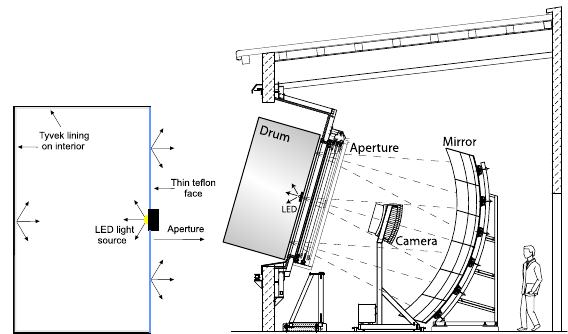
Figure 2. Left: The schematics of the Drum interior with the calibration LED source. Right: Schematics of the Drum absolute end-to-end calibration process [4].